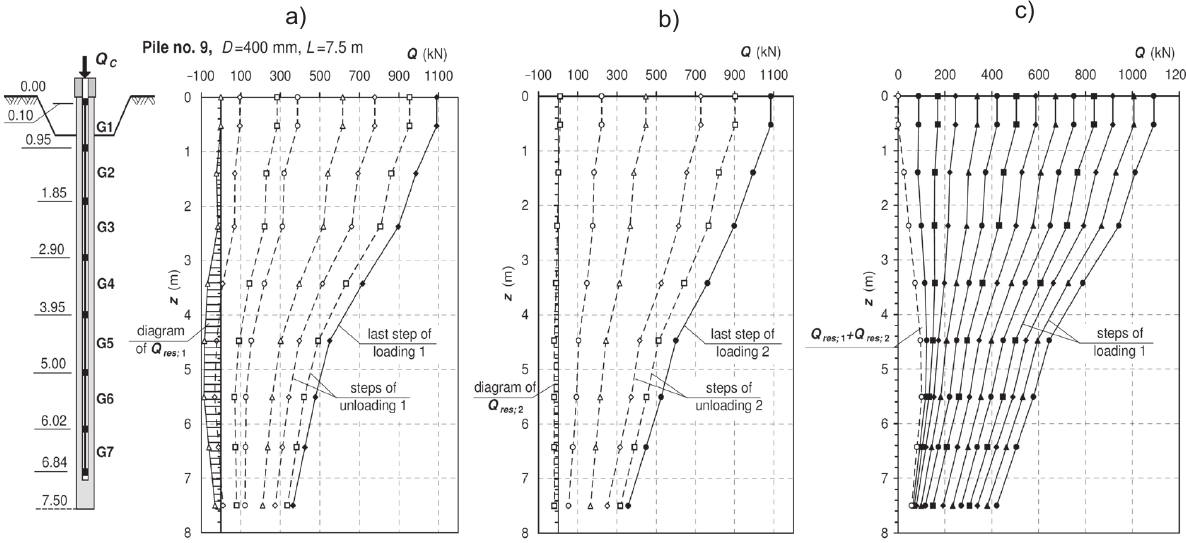
Figure 16: Pile no. 9, determination of the residual force in the pile shaft (a) after first unloading (b) after second unloading and (c) its inclusion in the distribution of the axial force along the pile in successive load steps.